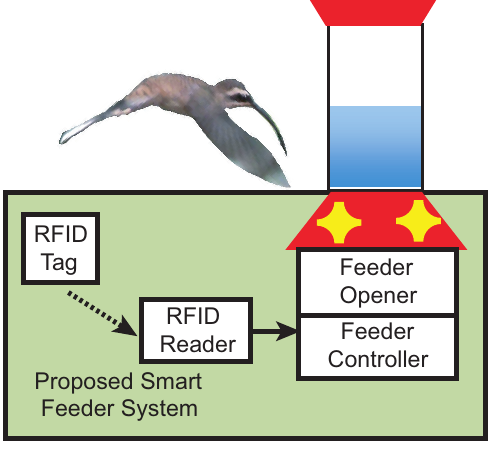
Figure 1. Proposed smart feeder system.